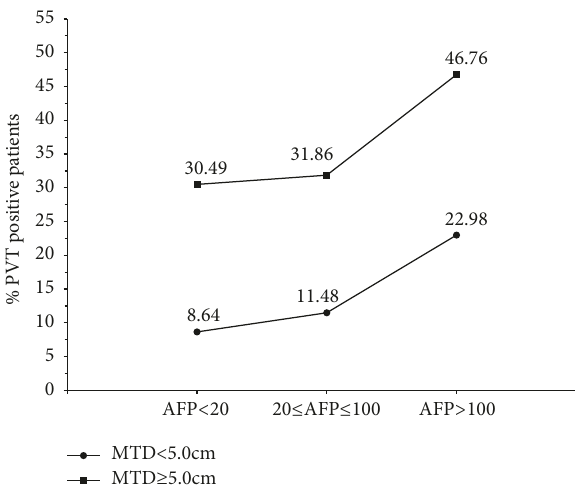
Figure 2: Percentage of patients with PVT in MTD (cm) categories: MTD < 5.0cm (p < 0.0001 ∗ ) and MTD ≥ 5.0cm (p < 0.0001 ∗ ) . ∗ Chi- square test for trend; PVT, portal vein thrombosis; MTD, maximum tumor dimension (cm); AFP, alpha-fetoprotein